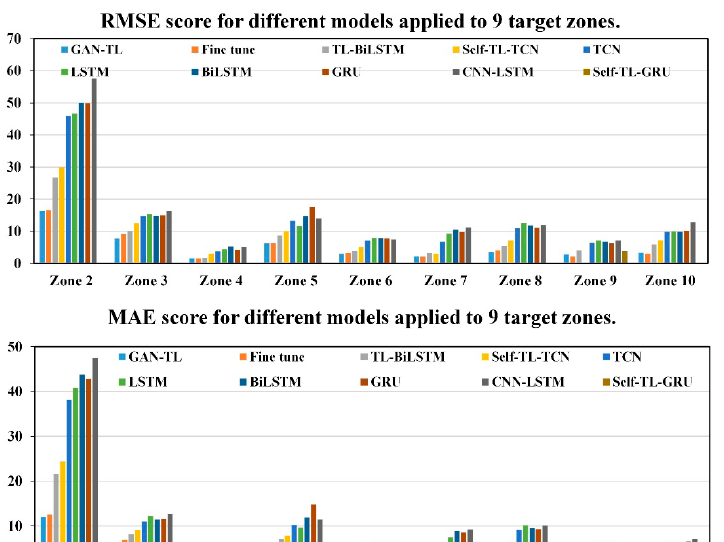
Figure 16. RMSE and MAE scores of different models applied to nine target zones.